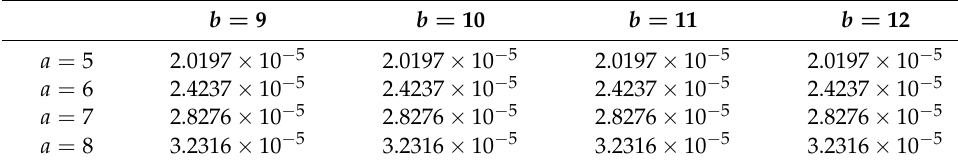
Table 6. The absolute error of expected value E [ X T ] with different parameters a and b